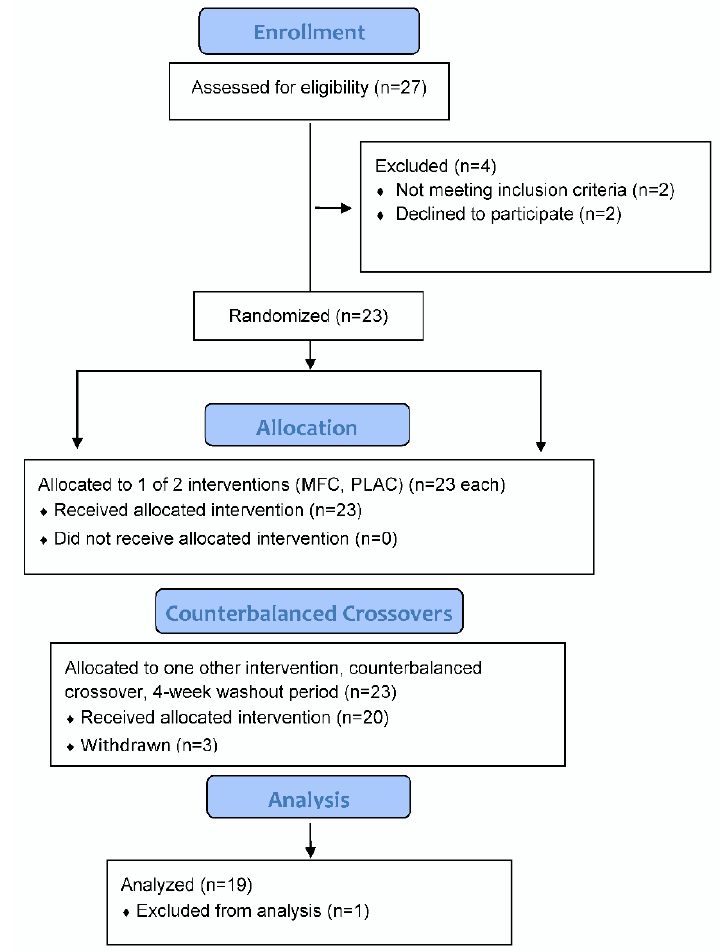
= mixed flavonoid-ca ff eine trial; PLAC = placebo